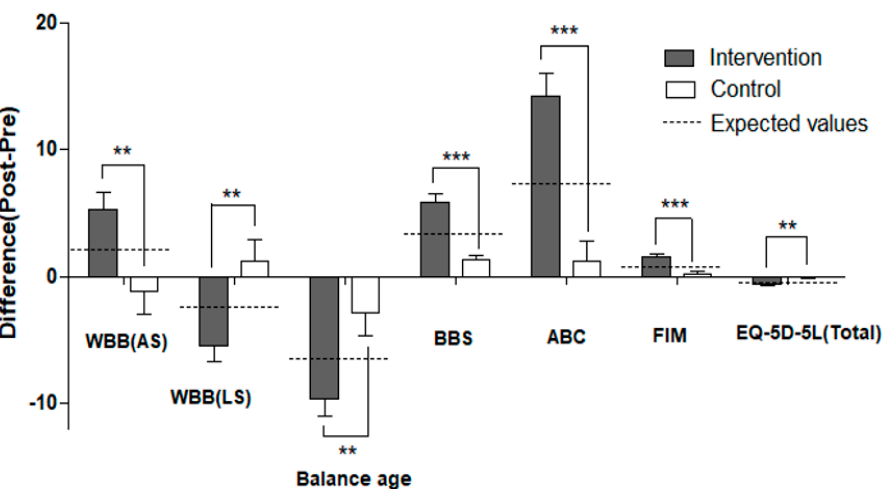
Figure 2. Representative outcomes showing significant group differences in this study. Values are mean ± SE; ** p < 0.01, *** p < 0.001; Dotted line: the expected value indicating an average of all variables from individuals in each outcome measure; WBB (AS/LS): weight distribution using Wii Balance Board in the affected side or the less affected side; BBS: Berg Balance Scale; ABC: Activities- specific Balance Confidence scale; FIM: Functional Independence Measure; EQ-5D-5L: EuroQoL 5 Dimensions (Total score). Table 3. Changes in balance and functional outcomes.